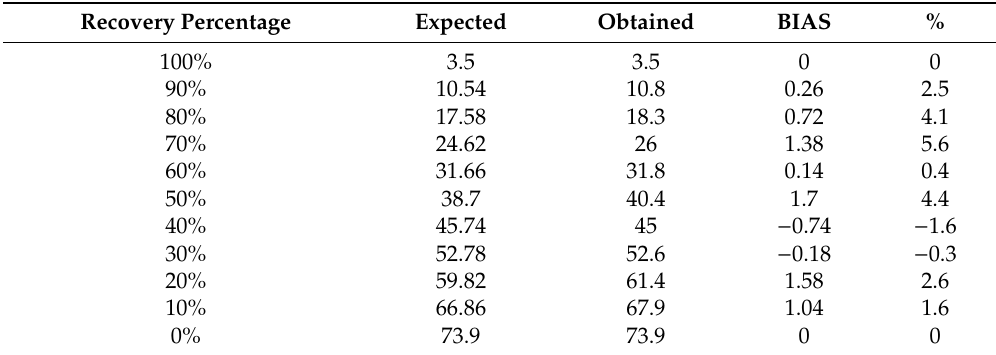
Table 2. Spike Recovery Test: comparison between expected and obtained results (pg / mL).